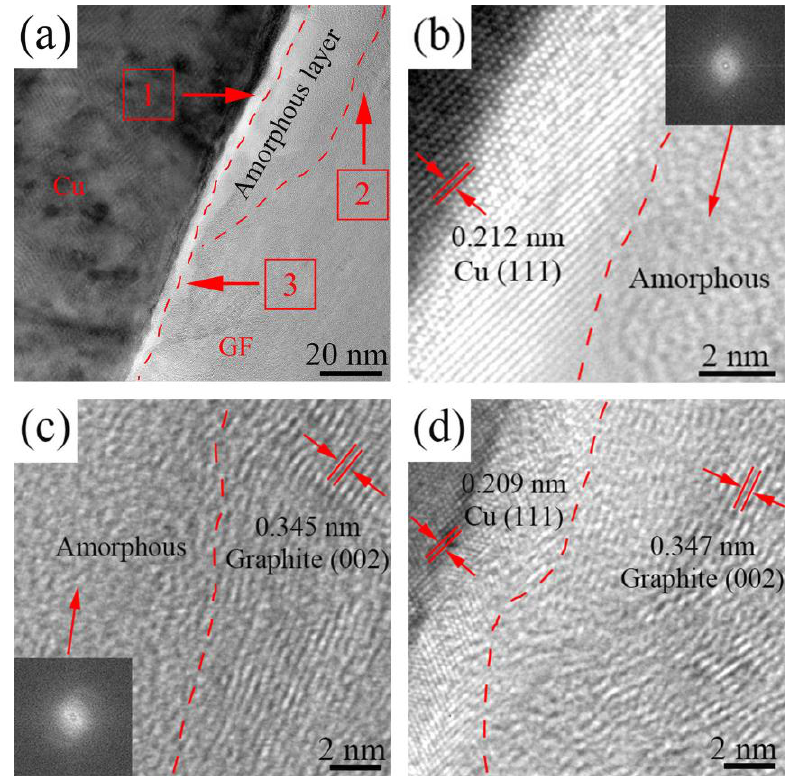
Figure 8. TEM observation of uncoated graphite flake/Cu composite: ( a ) typical Cu/GF interface photo, ( b – d ) HRTEM lattice image of position 1–3 in ( a ). ( b – d ) HRTEM lattice image of position 1–3 in ( a